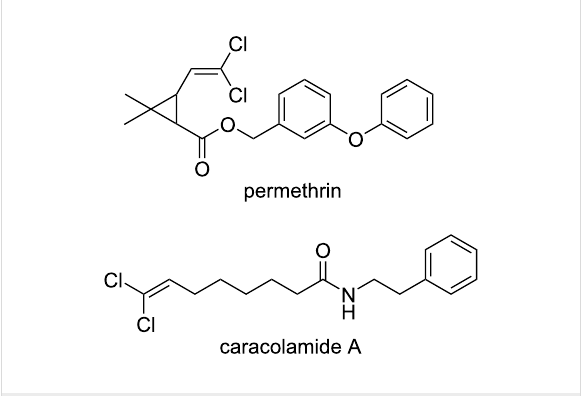
Figure 1: Examples of biologically active